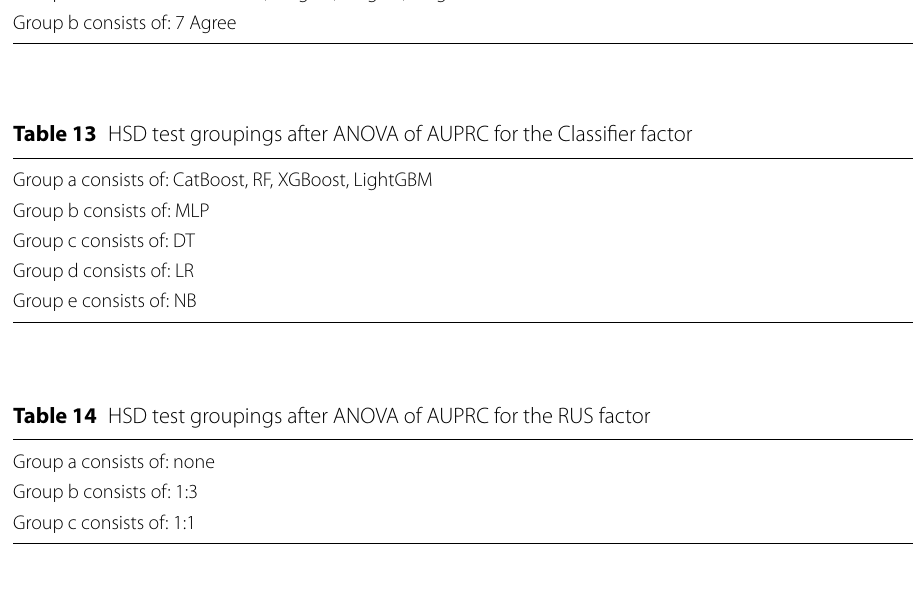
Table 12 HSD test groupings after ANOVA of AUC for the FST factor Group a consists of: All Features, 4 Agree, 5 Agree, 6 Agree Group b consists of: 7 Agree